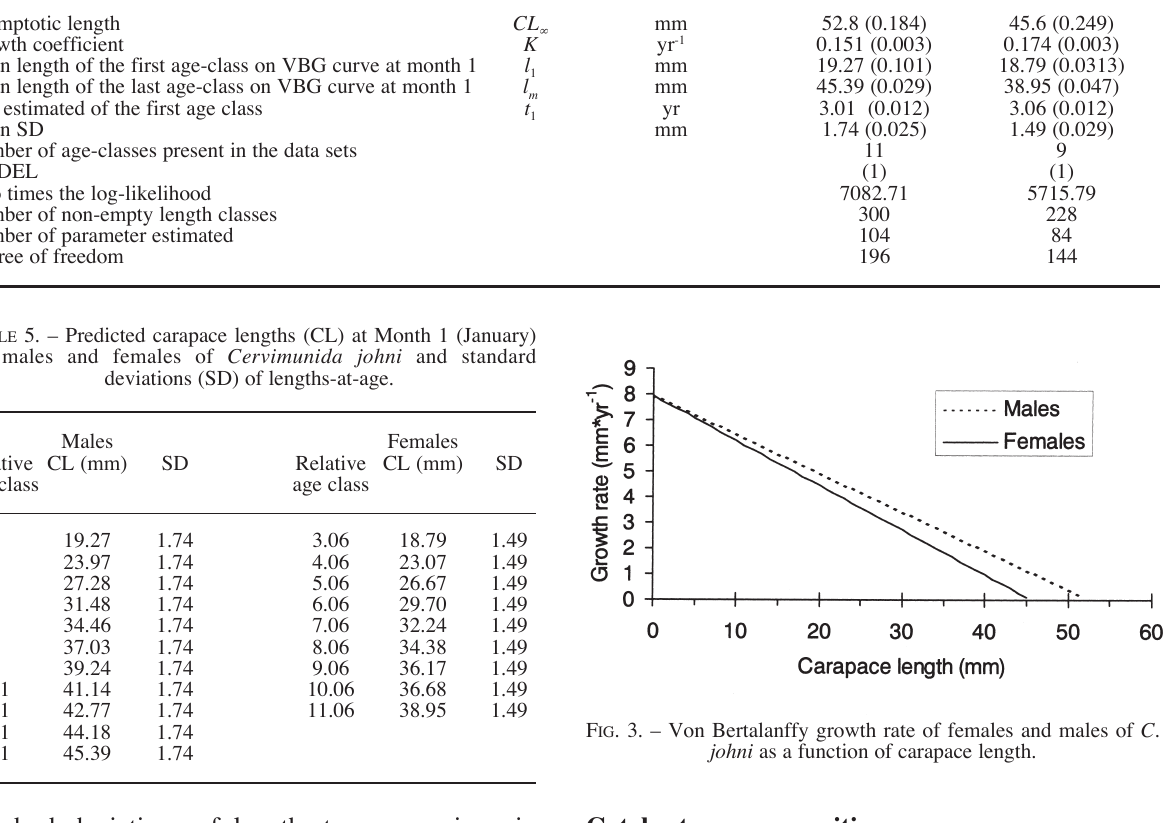
standard deviations of length-at-age are given in Table 5. There is a clear difference between the sexes in terms of parameterisation of their VBG function (Fig. 3).